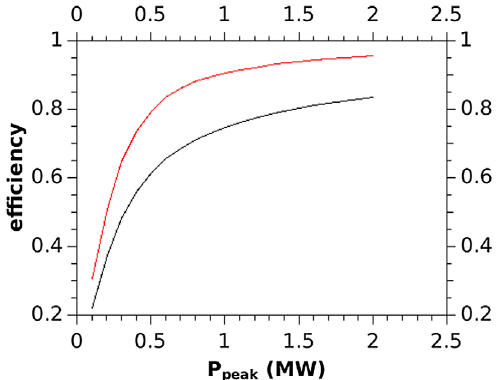
FIG. 10. Laser stripping efficiency with (red curve) and without (blue curve) dispersion tailoring.